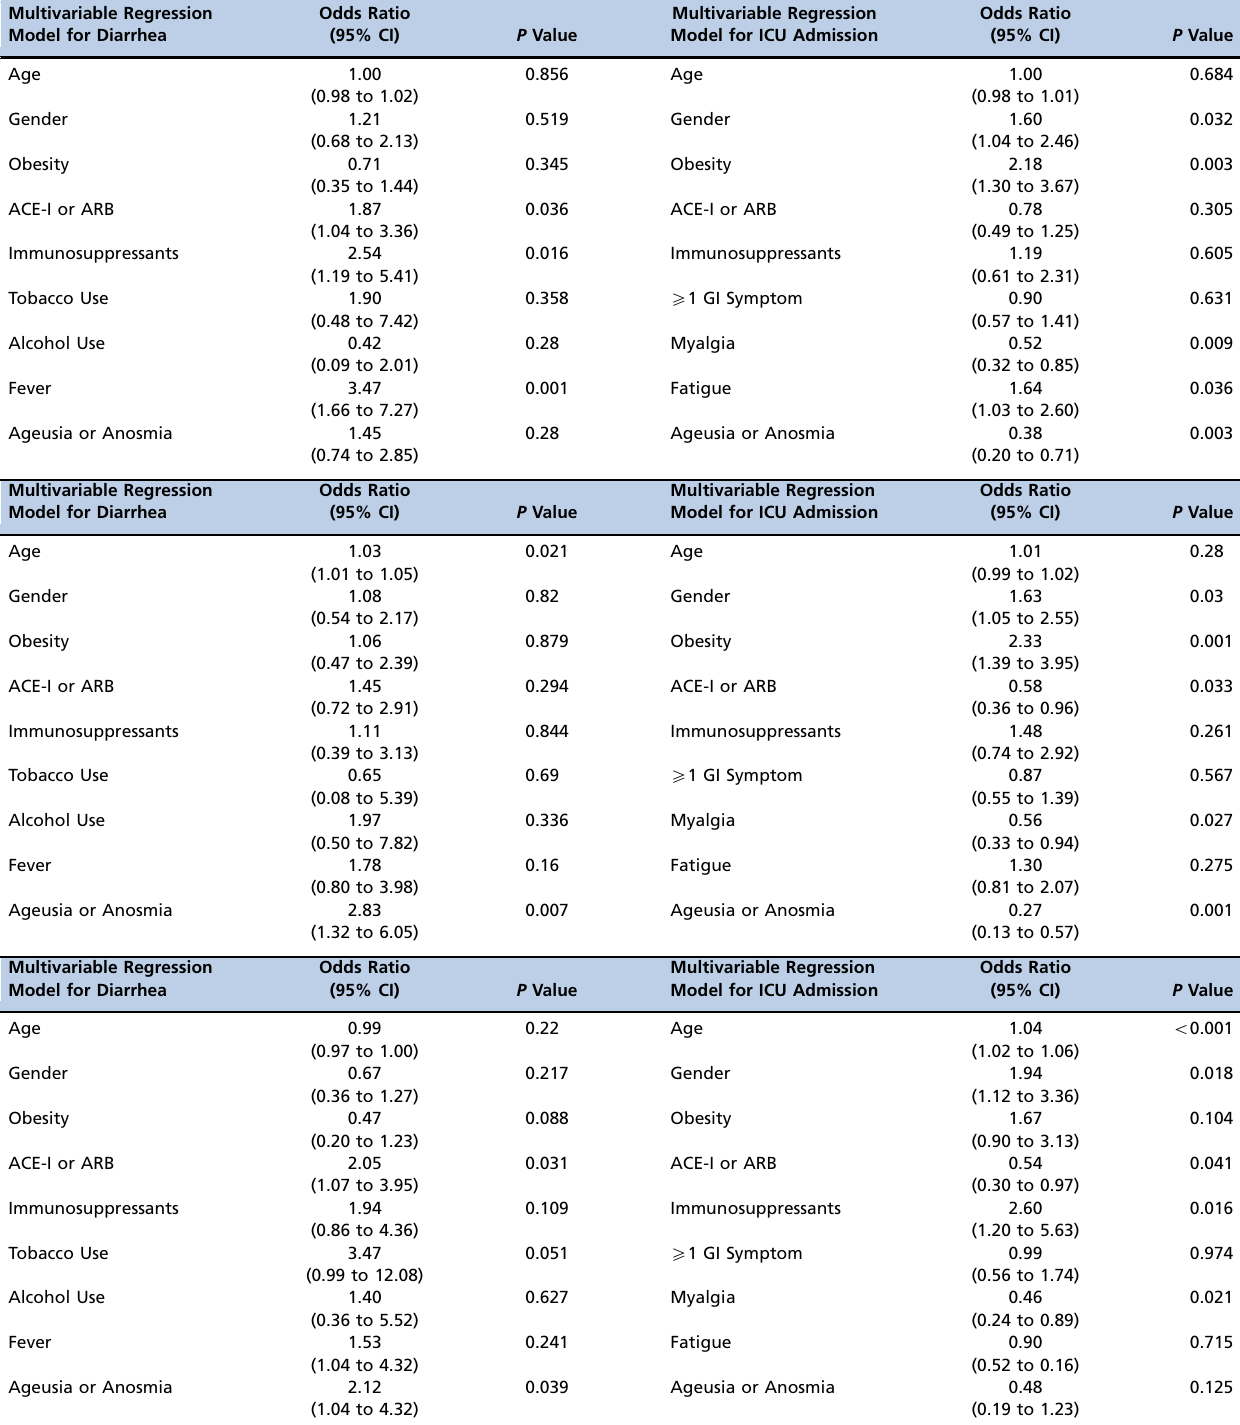
Table 4 - Multivariable Logistic Regression Model for Gastrointestinal Symptoms. Multivariable Regression Model for